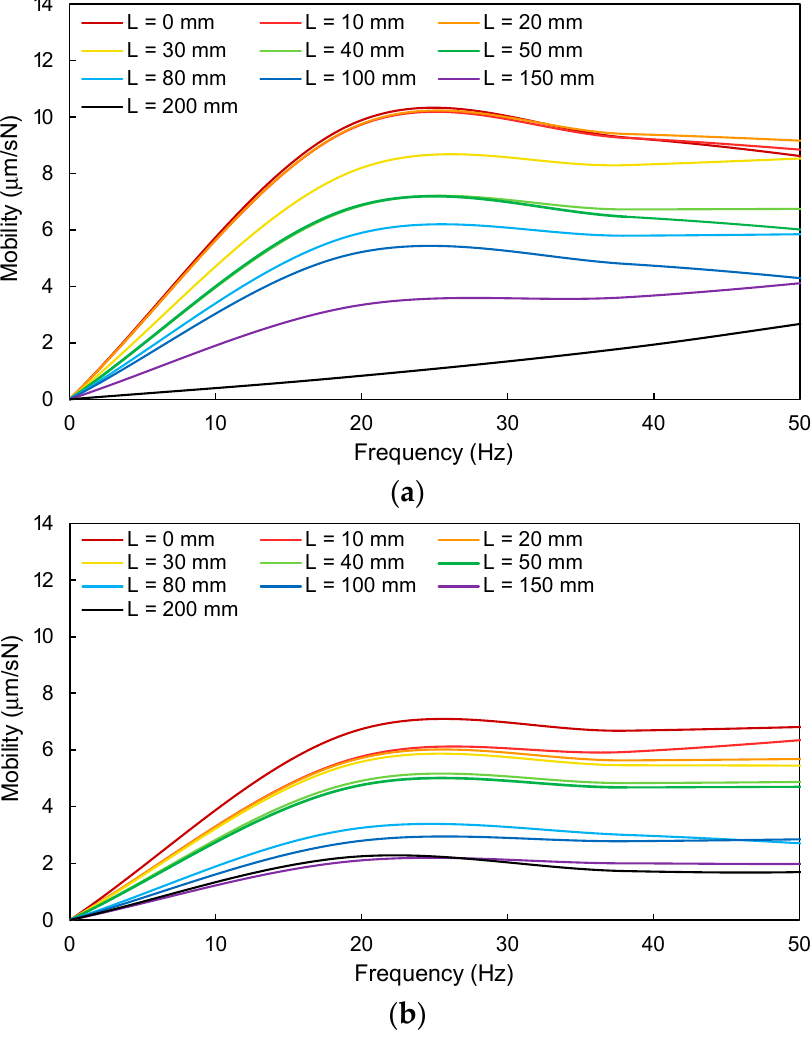
Figure 11. Mobility spectrum according to measurement location: ( a ) 8 mm thick acrylic plate and ( b ) 8 mm thick acrylic